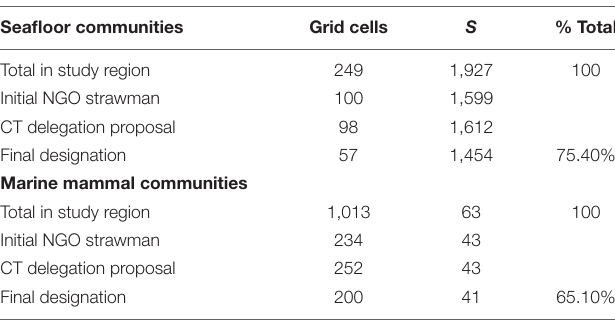
TABLE 1 | Comparison of species richness (S) represented by each boundary alternative as illustrated in Figure 1 . Seafloor